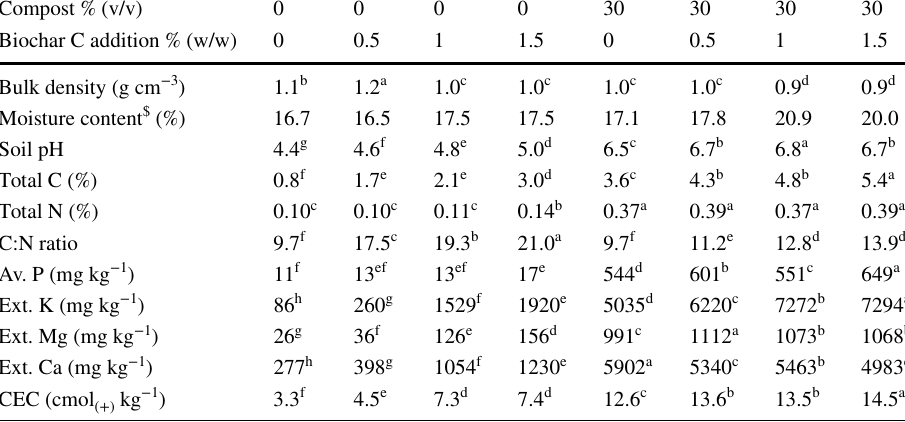
Av. available, Ext. extractable Moisture Content $ percentage of moisture content at − 33 kPa ( n = 1); within each row, means with differ- ent letters are significantly different at P ≤ 0.05 according to